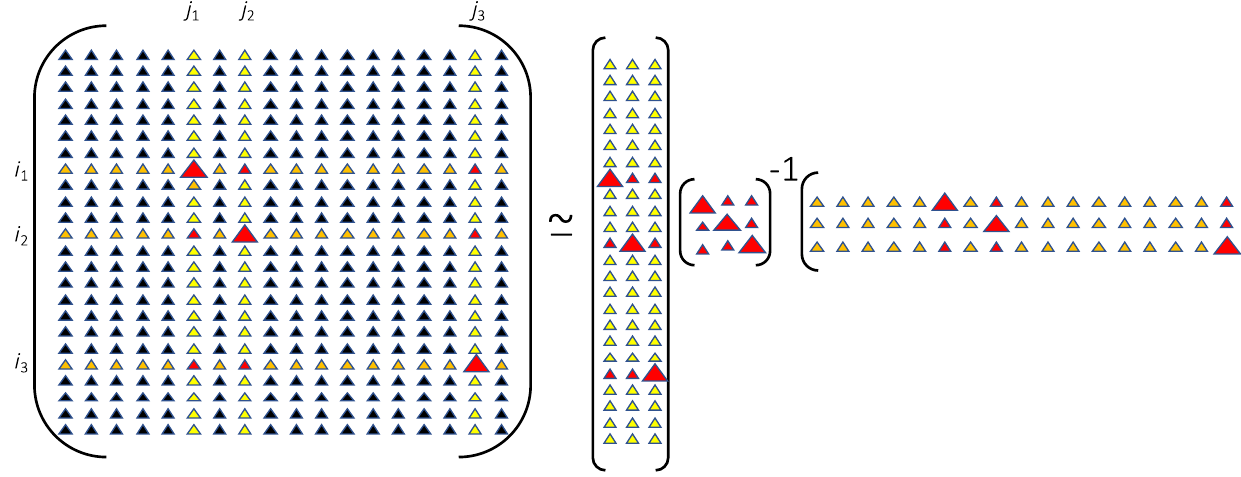
FIG. 2. Illustration of the CI of a matrix. The large red triangles indicate real pivots, and the smaller red triangles indicate automatically generated pivots. The right-hand side contains only small subparts of the